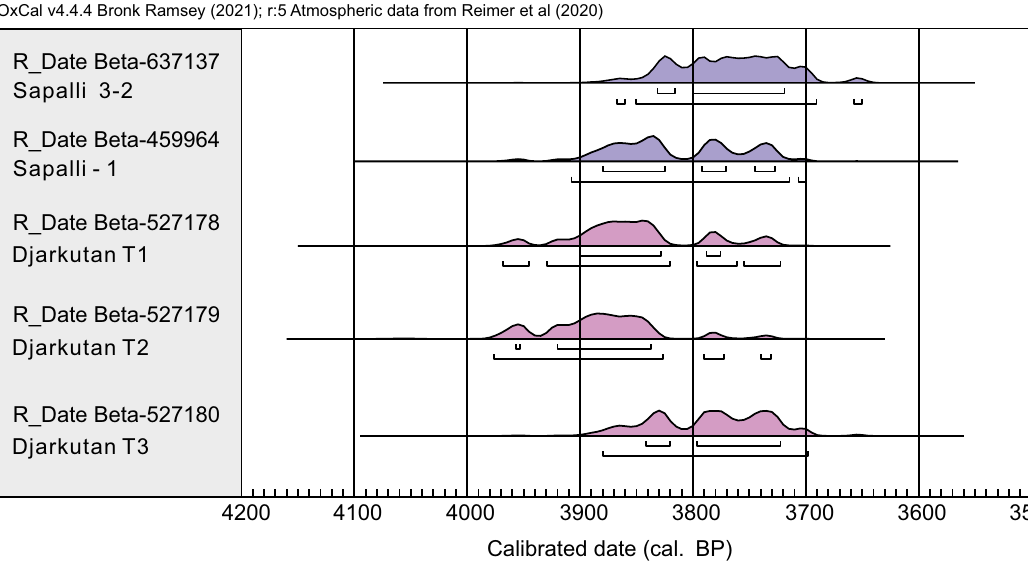
Figure 2. Dorsal view of an archeological specimen with indications of linear morphometric measurements ( a ) and morphological differences between modern cultivated grapes ( b ) and wild grapes ( c ).